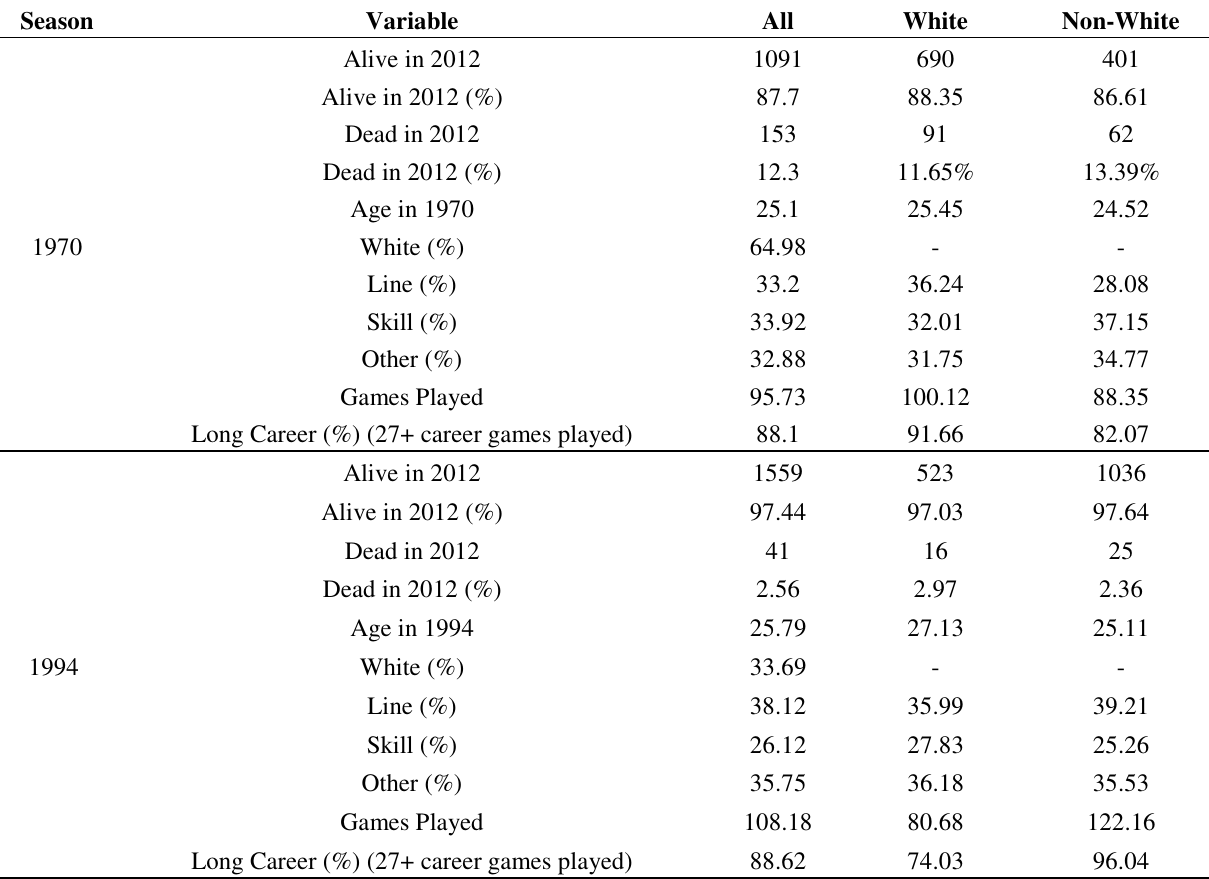
Table 1. Summary